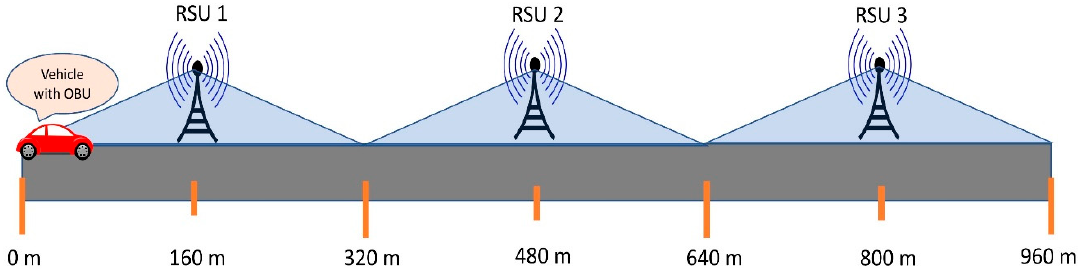
Figure 9. Testing setup of the track with one vehicle and three RSU.